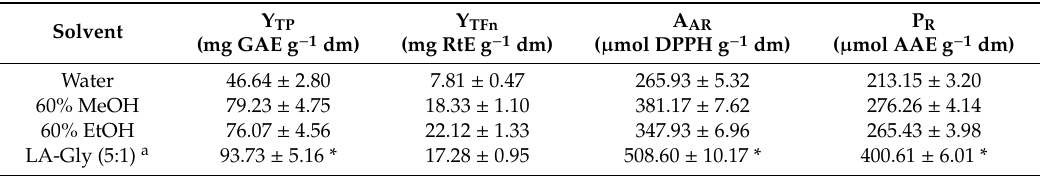
Table 2. Yields in total polyphenols (Y TP ) and total flavonoids (Y TFn ), as well as antioxidant characteristics of the extracts produced with La-Gly (5:1) and control solvents.